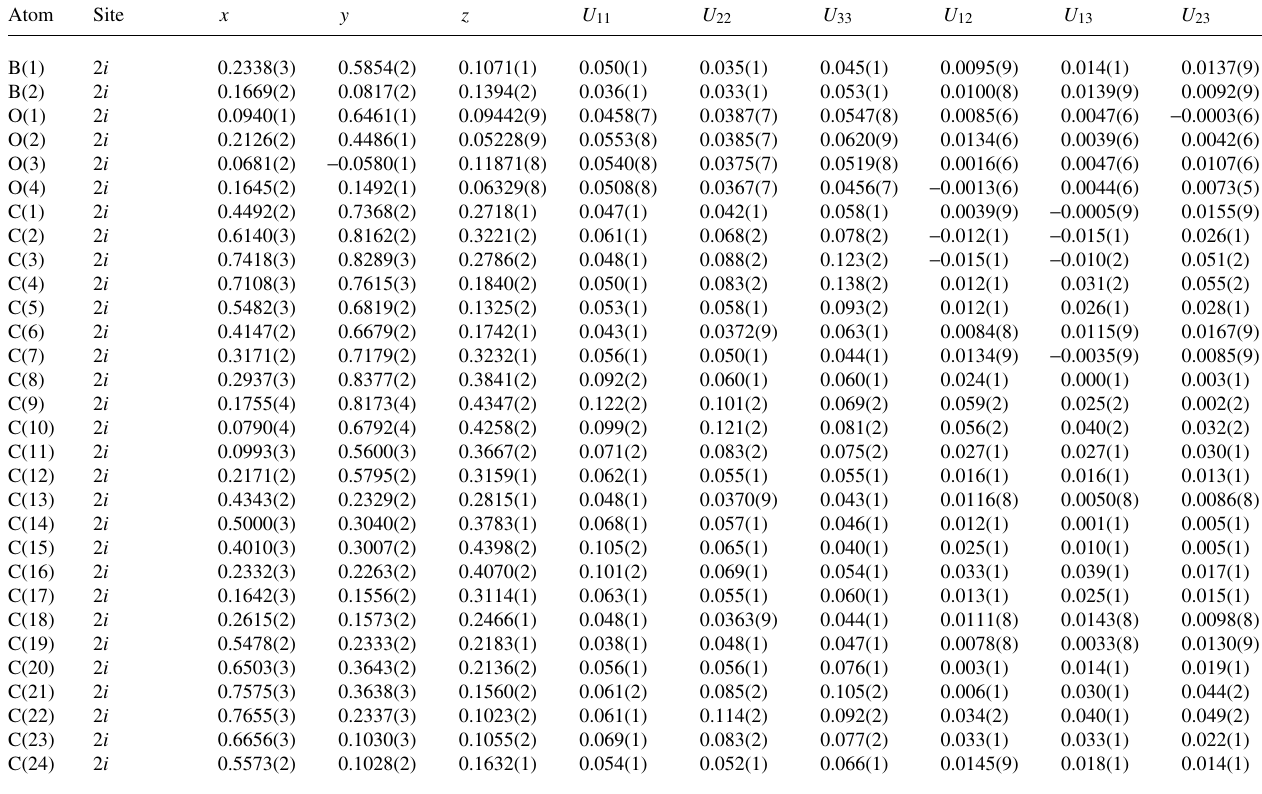
Table 3. Atomic coordinates and displacement parameters (in Å 2 )